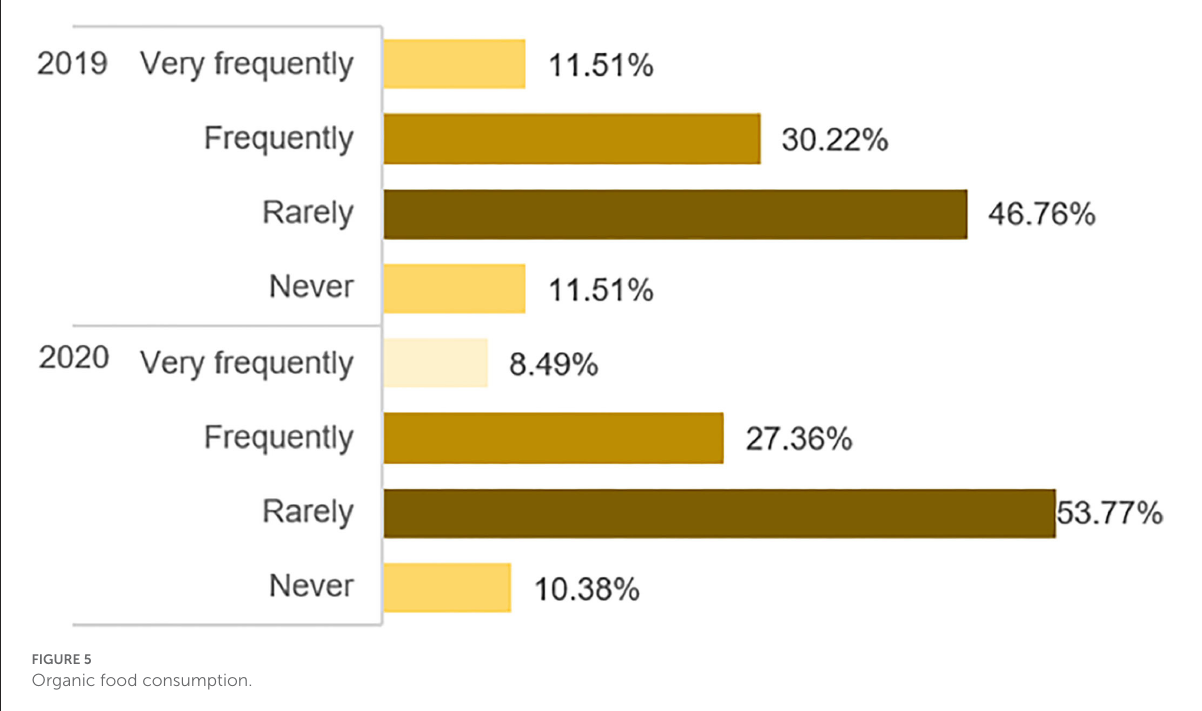
FIGURE5 Organic food consumption.